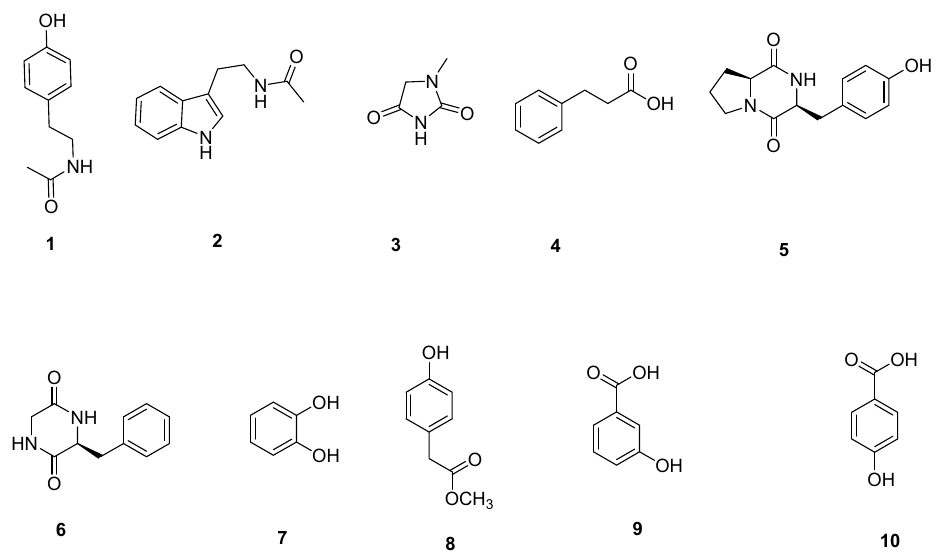
Table 1. The nematicidal activities of compounds against M. incognita .